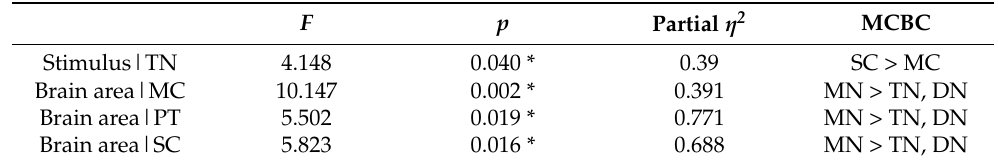
Table 4. Results of simple effect analysis of the amplitudes for N1 for the experiments recruiting reflexive